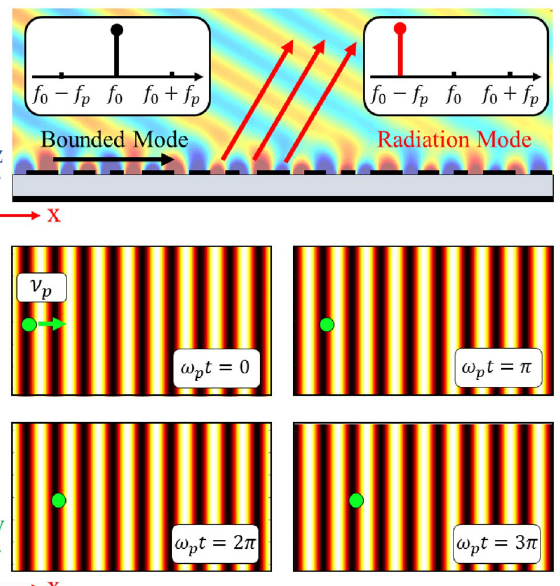
Figure 2. Scalar surface impedance patterns for different time slots. The circular indicator shows the progression of impedance with